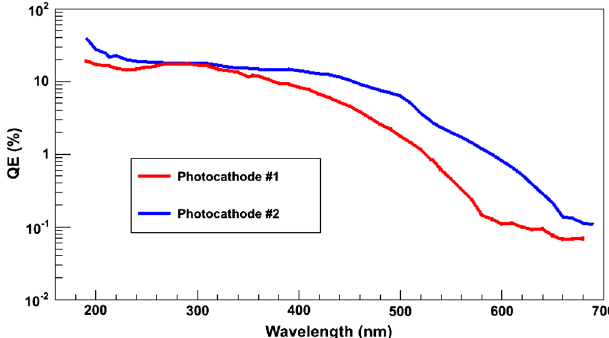
FIG. 2. Spectral response of the K 2 CsSb photocathodes cre- ated at BNL just after deposition.